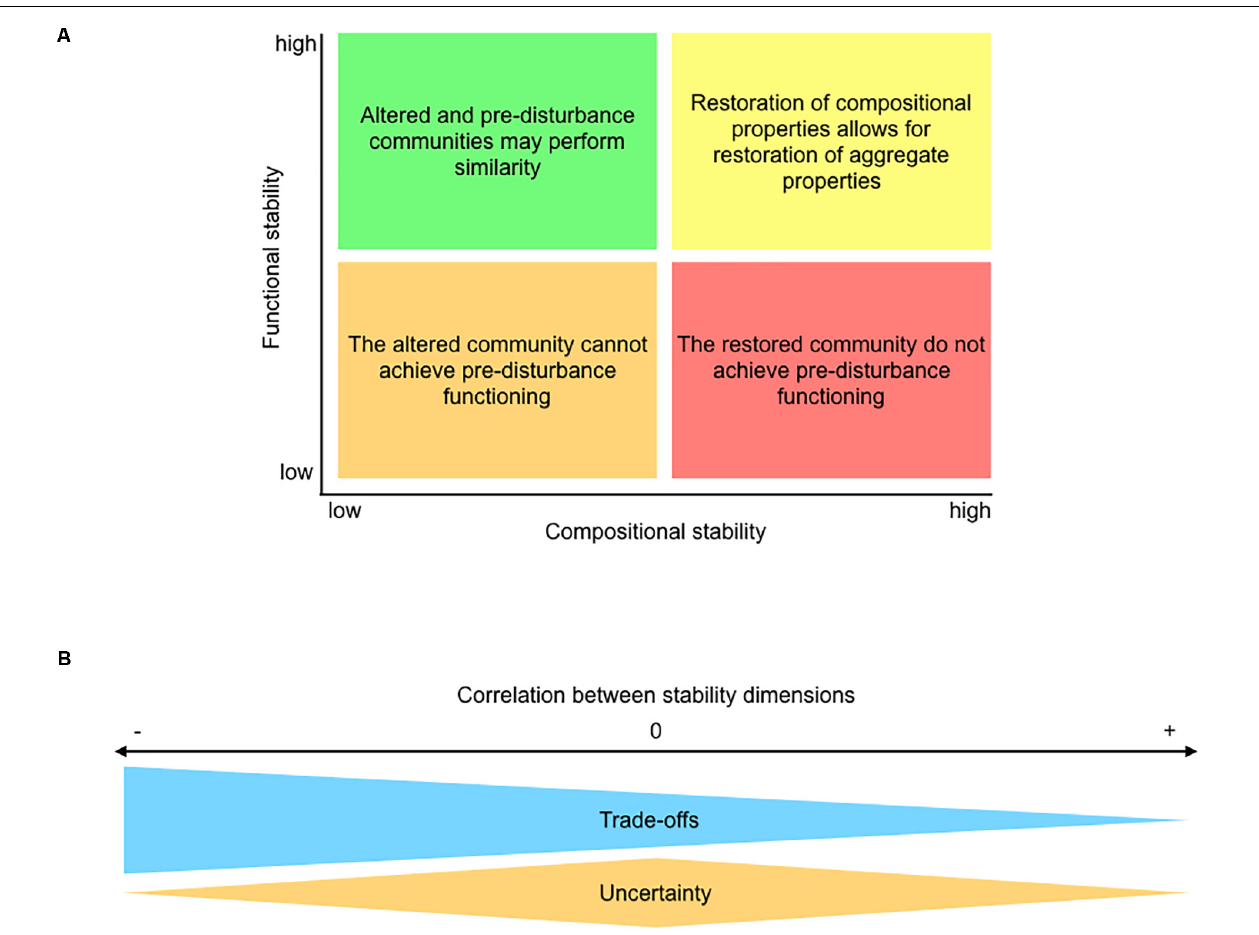
FIGURE 7 | Summary of scenarios based on correlations between (A) functional and compositional stability domains and (B) stability dimensions. Panel (A) Systems exhibiting positive functional-compositional stability correlations may need a full recovery in species composition to achieve a full recovery in functioning (yellow quadrant); if not, no functional recovery would be possible (orange quadrant). Contrarily, negative functional-compositional correlations (e.g., barnacle communities in this study) imply that the altered community may be able to compensate the functioning of the pre-disturbance community, but also that restored communities are unable to recover pre-disturbance functional values. Panel (B) A positive correlation between two aspects of stability (e.g., functional resistance and invariability; this study) indicates that and conservation decisions could improve both aspects of stability; a negative correlation (e.g., functional resistance and resilience; this study) implies that policy trade-offs will be crucial to maintain either one or another aspect of stability. The lack of correlation among stability dimensions (e.g., all compositional dimensions in this study) indicates that, due to high uncertainty, multiple aspects are mandatory to characterize the stability of the